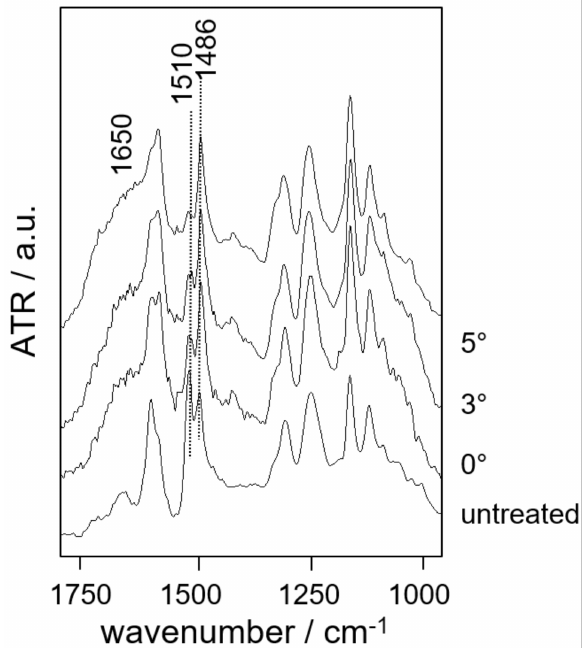
Figure 16. Infrared spectra ( µ -ATR-FTIR) in the center of the samples’ back side (position 2 in Figure 2) with a given out-of-plane fibre angle after 300 s of hot-air